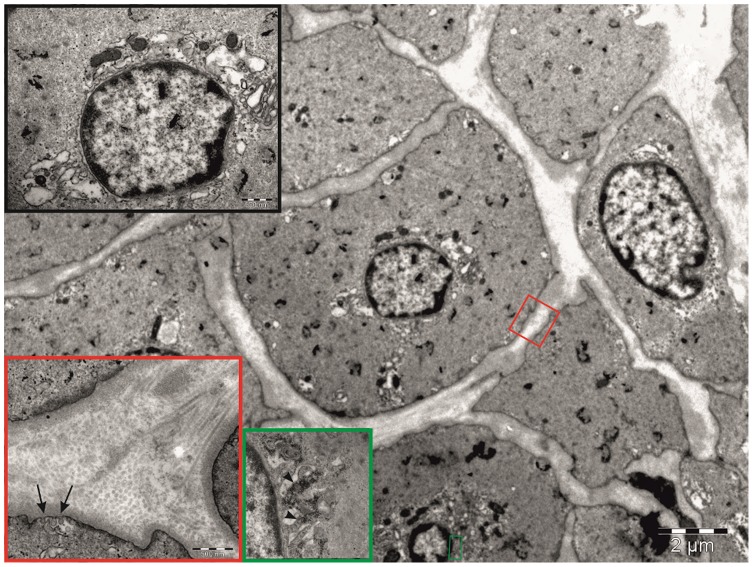
TEM analysis of a graft from an SVGD (+) patient.Electron micrograph of a cross section through the tunica media layer of the saphenous vein obtained from an SVGD (+) patient. Characteristic nuclei with heterochromatin are present at the periphery. The organelles are concentrated in proximity to the nucleus (black inset), and the extracellular matrix attached to densely packed and organized collagen fibers (red inset). Note the small invaginations of cell membrane forming caveolae (arrows) and the numerous glycogen deposits (arrowheads, green inset).